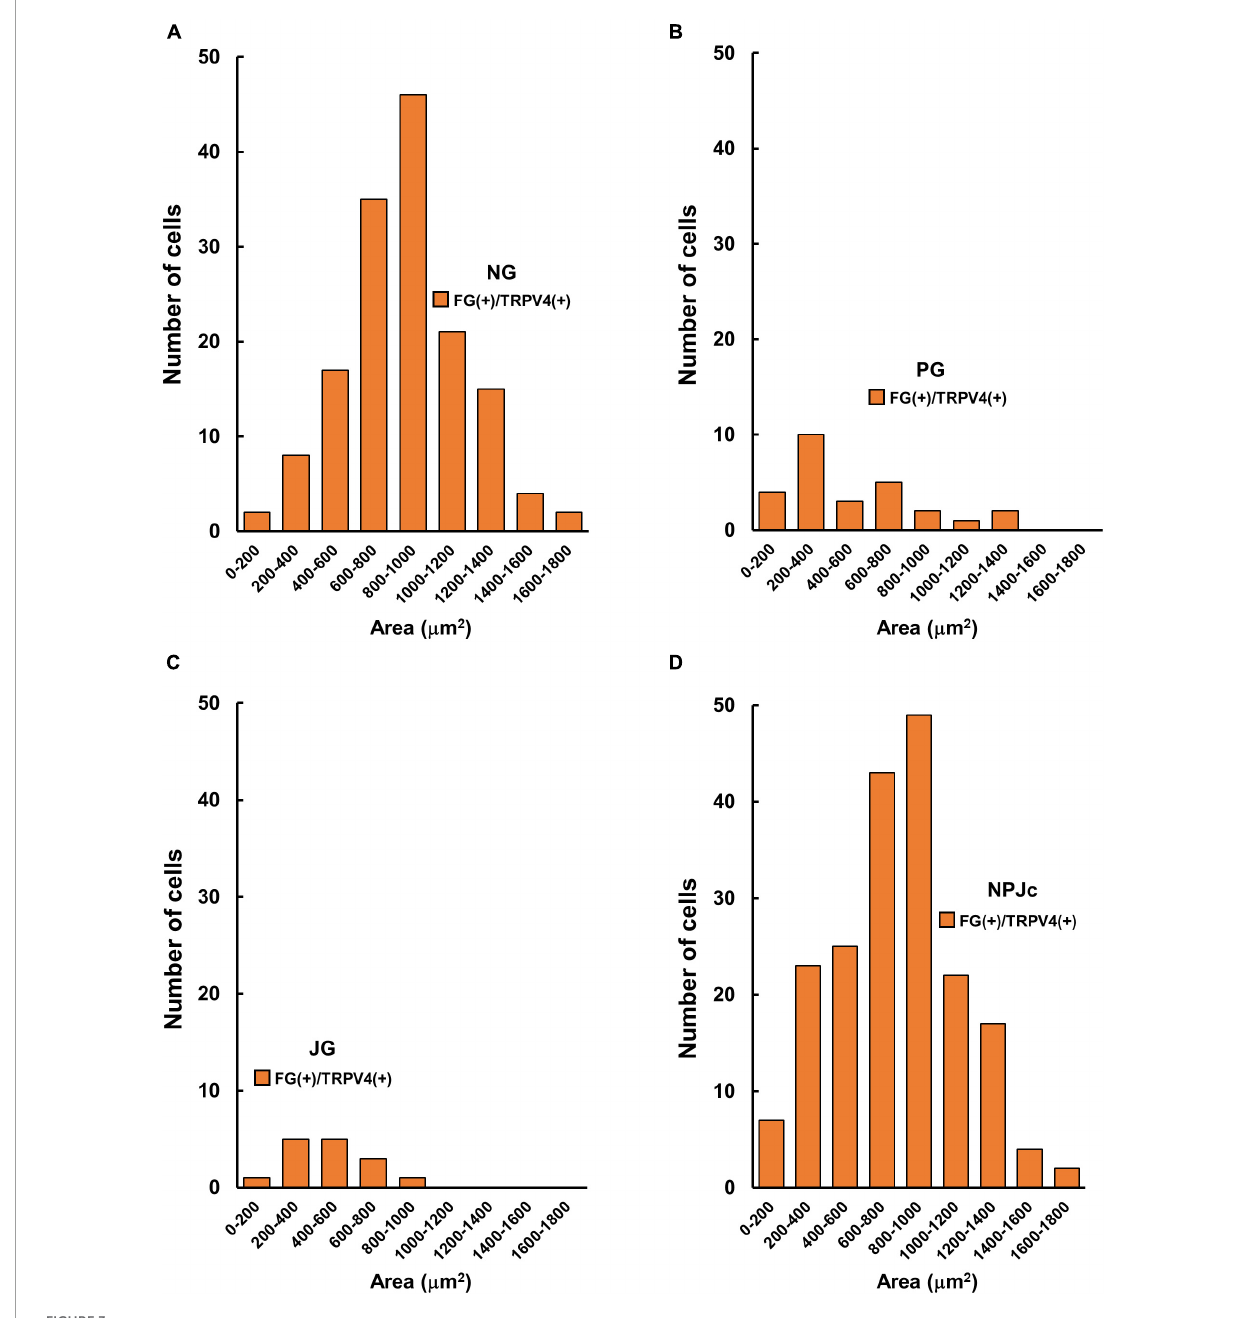
FIGURE3 TRPV4-positive cell size in the NPJc. (A) Size (area) distribution of TRPV4-positive cells in the nodose ganglion (NG). (B) Size (area) distribution of TRPV4-positive cells in the petrosal ganglion (PG). (C) Size (area) distribution of TRPV4-positive cells in the jugular ganglion (JG). (D) Size (area) distribution of TRPV4-positive cells in the whole NPJc. FG+/TRPV4+, FG-stained cells immunopositive for TRPV4; n = 5. Six sections were used from each rat (two